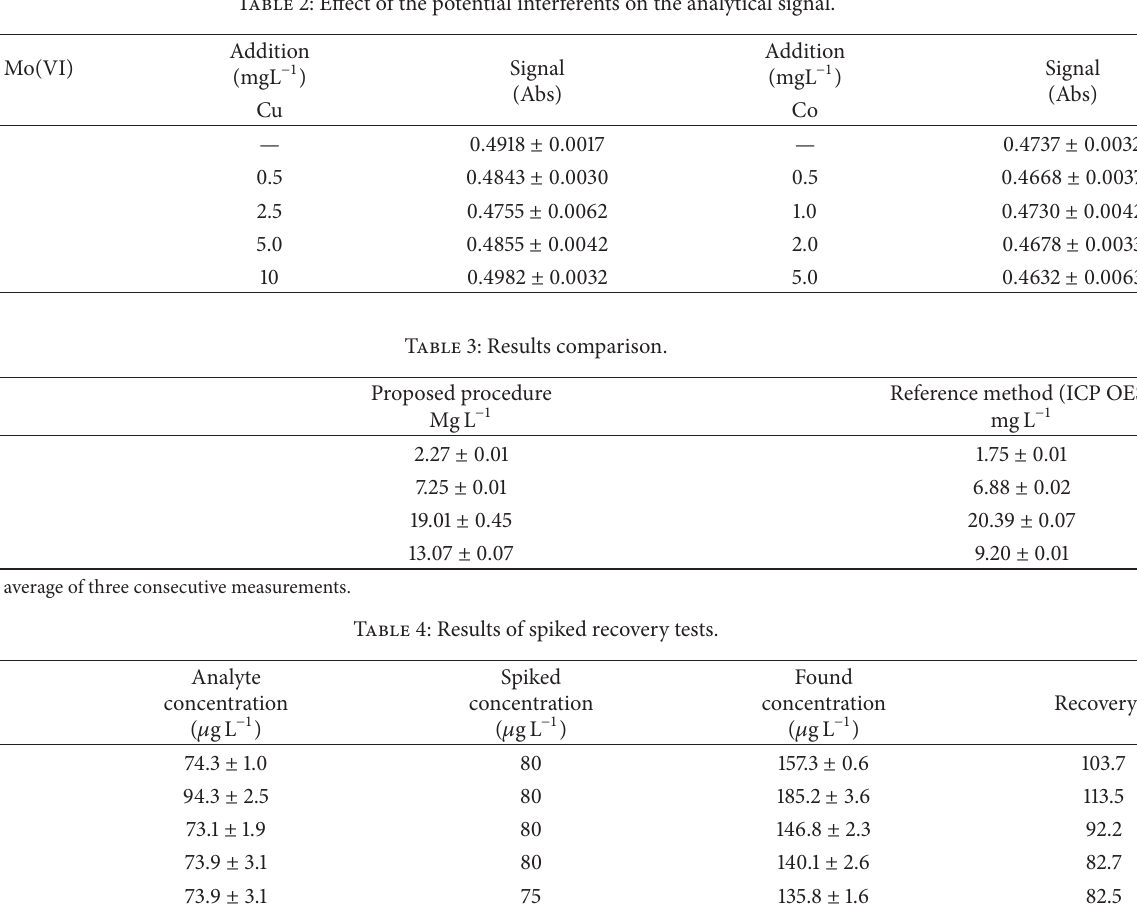
Table 2: Effect of the potential interferents on the analytical signal.